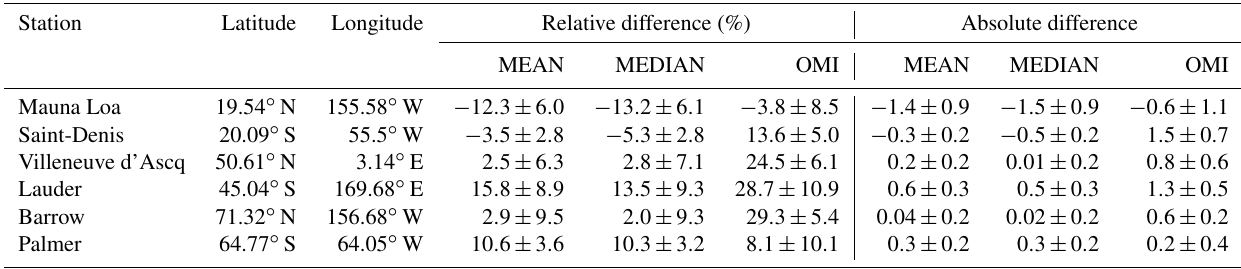
Table 4. Mean UVI relative and absolute difference of the monthly climatology between UVI MEAN , UVI MEDIAN and UVI OMI to the ground-based measurements (UVI GB ). If we define the UVI from ground-based measurements as UVI GB , the differences are calculated as − UVI GB follows: relative difference is defined as RD = 100 UVI MEAN ; absolute difference is defined as RD = UVI MEAN − UVI GB . The same UVI GB calculation applies to UVI MEDIAN and UVI OMI . For Barrow and Palmer station we selected the summer months of June, July and August and December, January and February respectively.